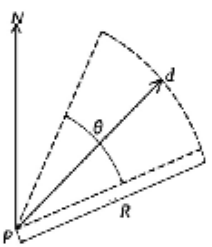
Figure 2. Theoretical field of view of Frame in 2D